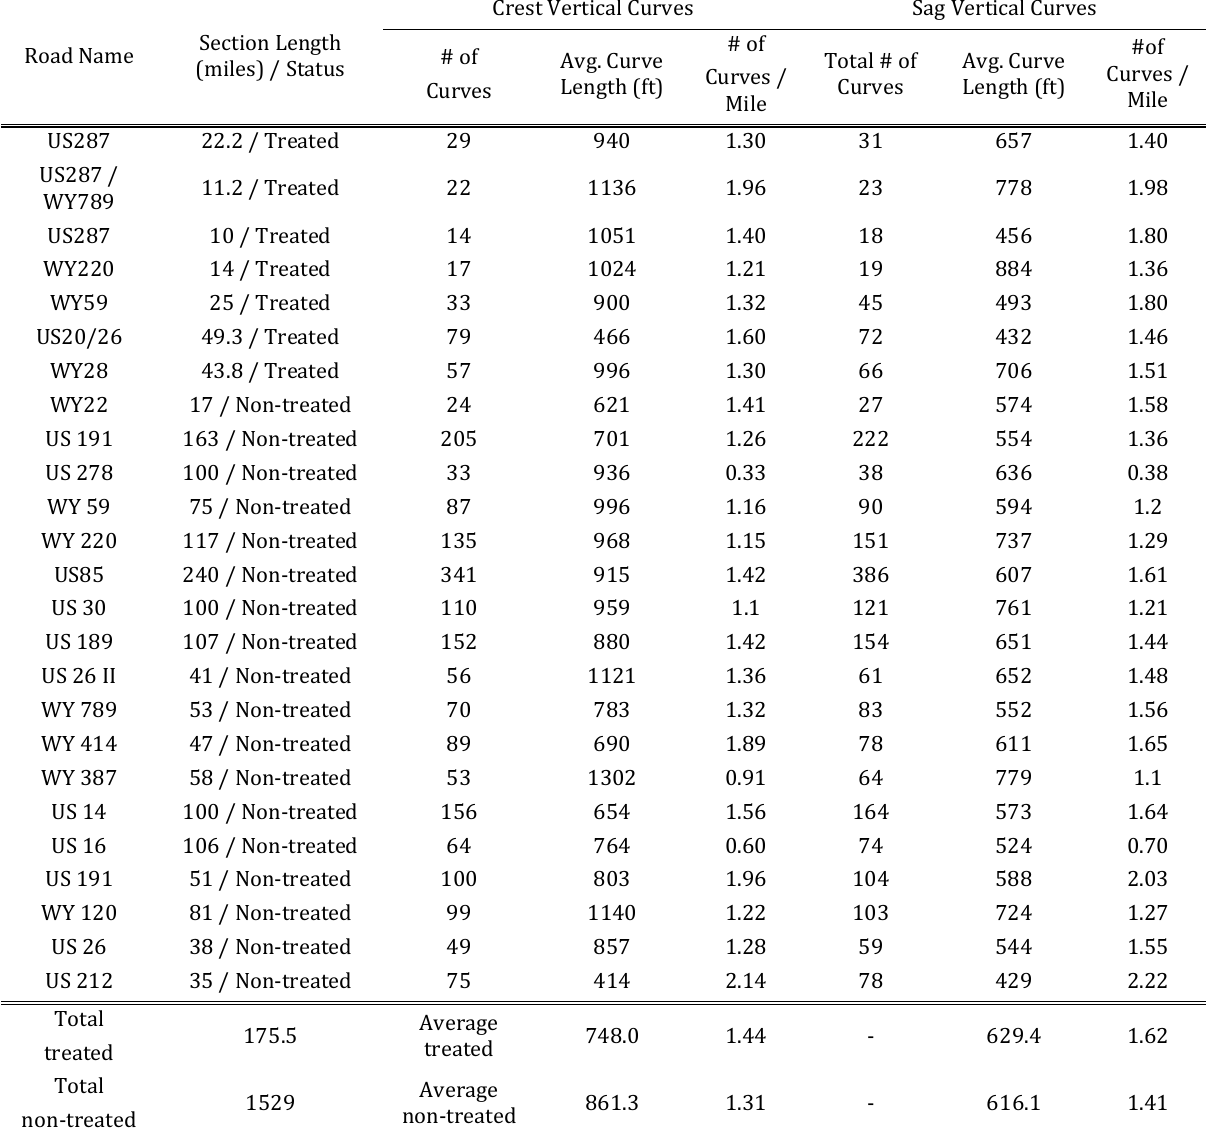
Table 2: Vertical Alignment Characteristics of Headlight and Non –Headlight Sections Road